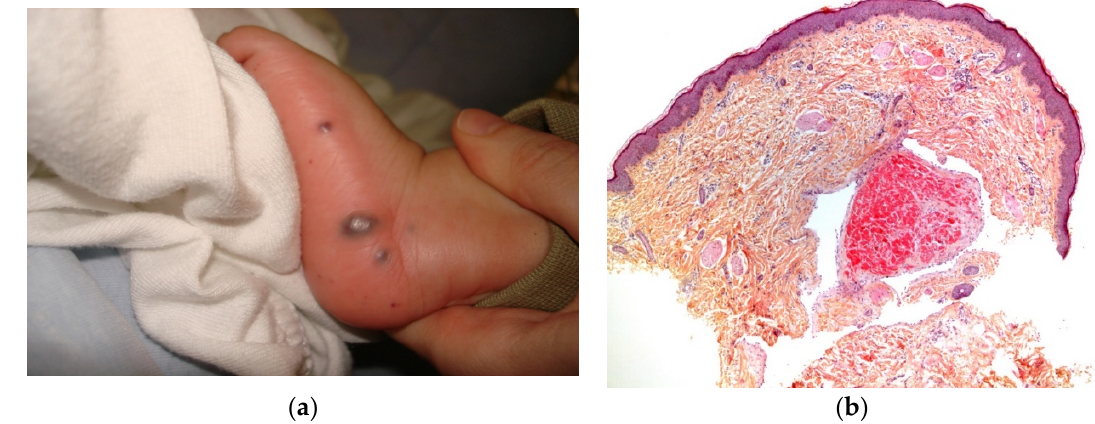
Figure 17. A blue rubber bleb nevus syndrome. ( a ) Blue nodules on the foot. ( b ) 4× dilated venous vessels, some of them containing thrombi